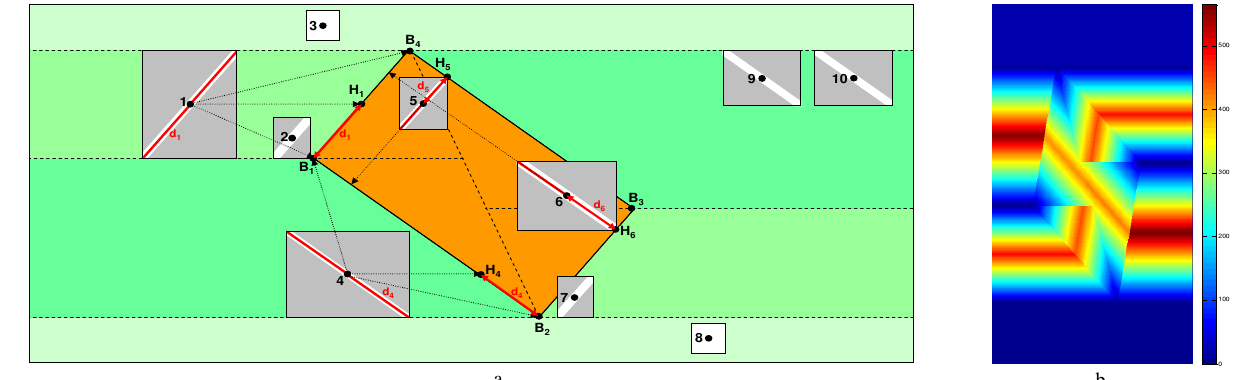
Figure 1. Adaptive phase filtering: a) schema of filter approach and b) 2D histogram of adaptive filter size [pixel are